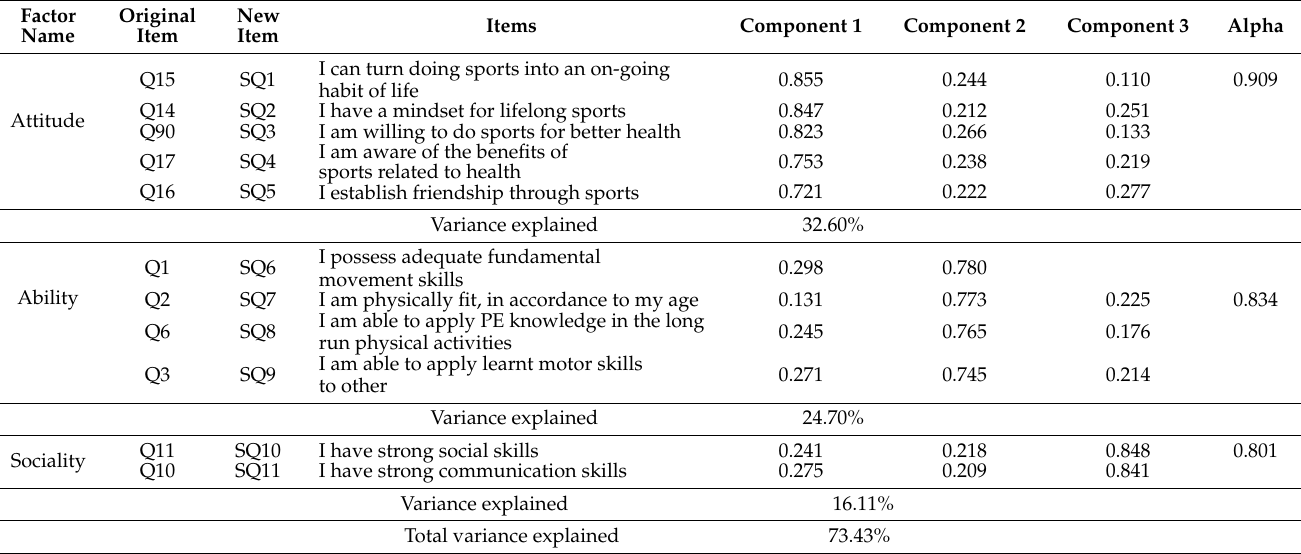
Table 3. Second factor structures by exploratory factor analysis ( n =